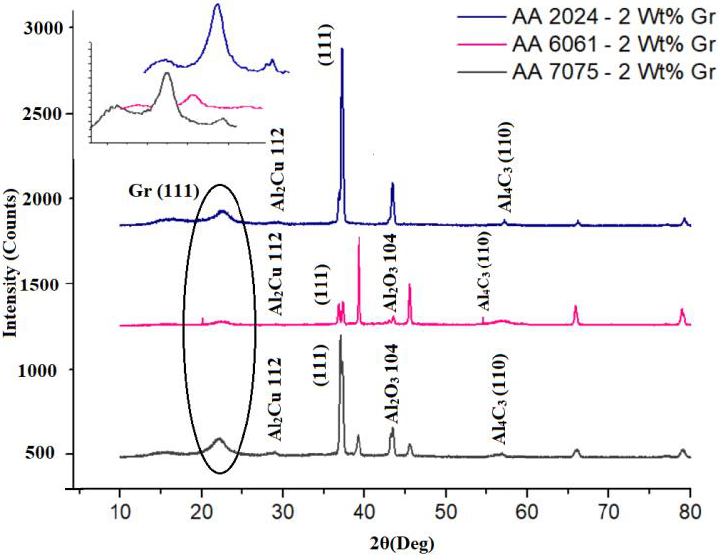
Figure 11. XRD Pattern for AA2024, AA6061 and AA7075 – 2 Wt% Gr Nano